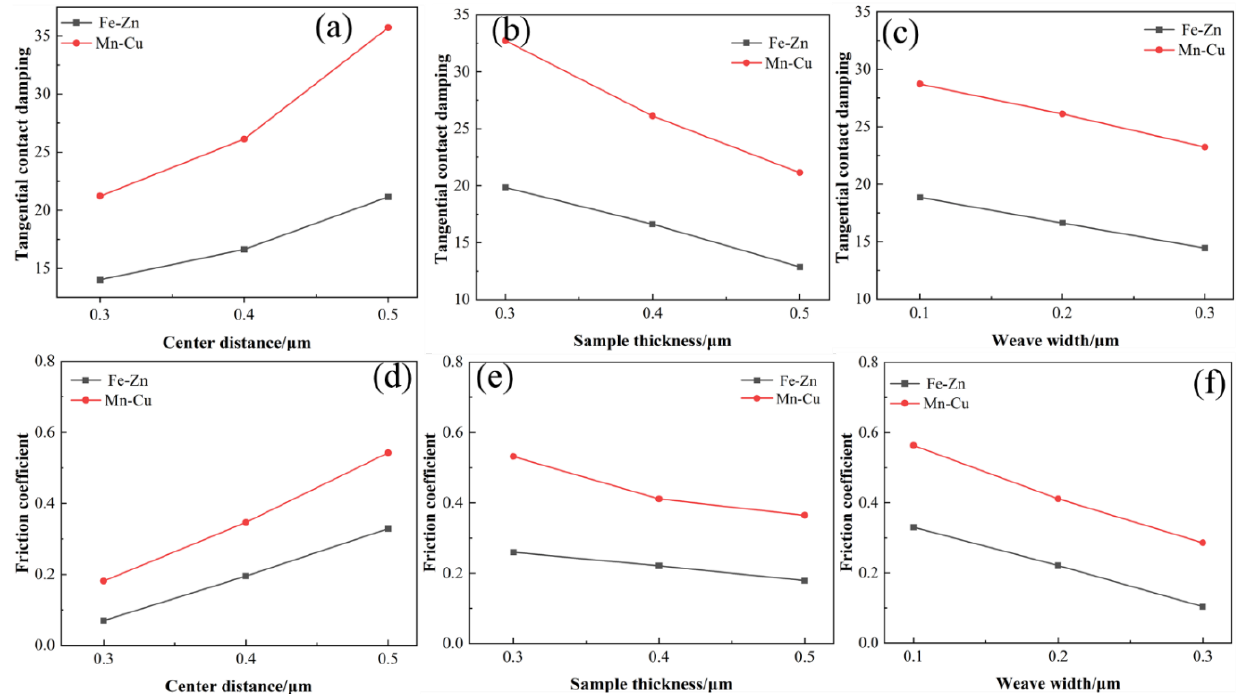
Figure 7. Tangential contact damping of the samples. ( a ) The relationship between Tangential contact damping and center distance. ( b ) The relationship between Tangential contact damping and Sample thickness. ( c ) The relationship between tangential contact damping and weave width. ( d ) The relationship between Friction coefficient and center distance. ( e ) The relationship between Friction coefficient and Sample thickness. ( f ) The relationship between Friction coefficient and Weave wideth.